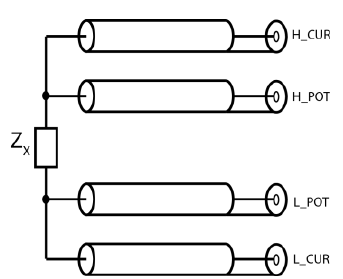
Fig. 2. Electrode configuration. Z x represents board impedance measurement. H_CUR and L_CUR are connected to ground electrodes, while H_POT and L_POT are the sense electrodes.